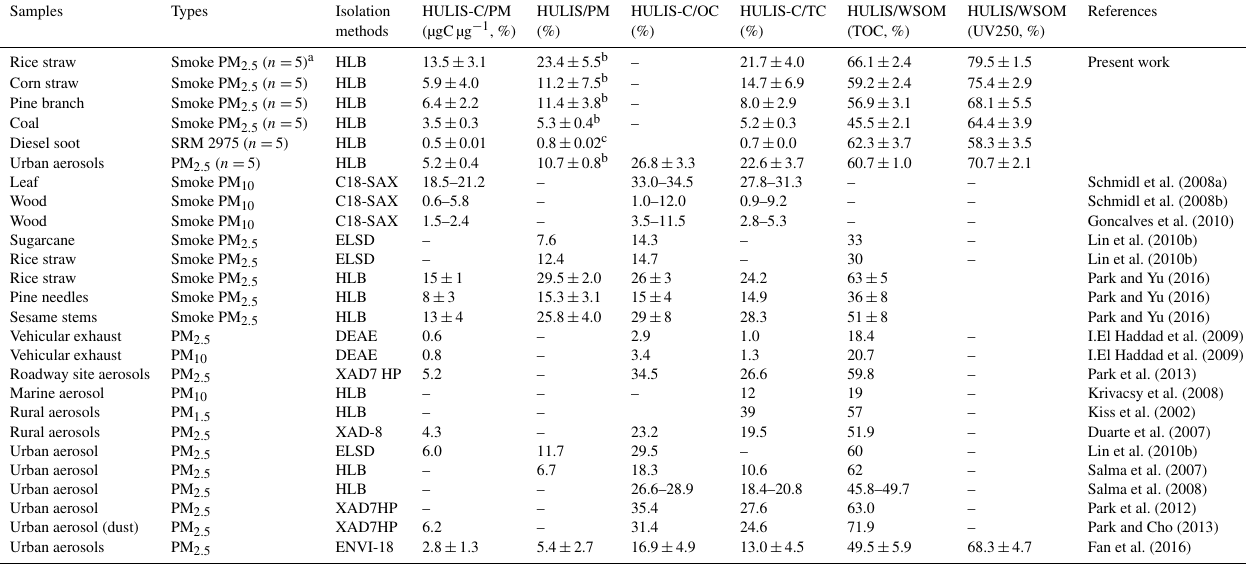
Table 2. The contributions of HULIS to particular matter (PM), total carbon (TC), and water-soluble organic matter (WSOM) in smoke PM 2 . 5 emitted from combustion of biomass materials and fossil fuels, and in ambient PM 2 . 5 . Samples